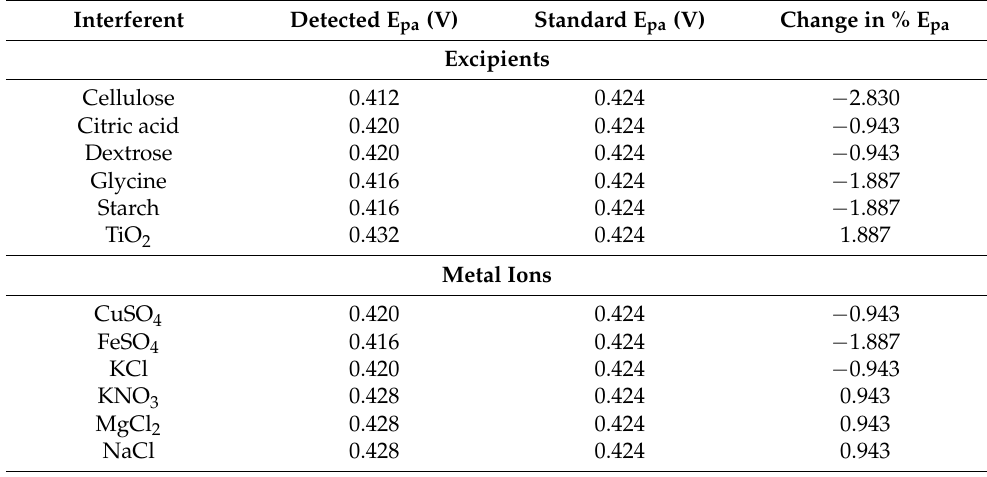
Table 3. Findings about the influence of interferents on the electrochemical response of 0.01 mM ZLT.